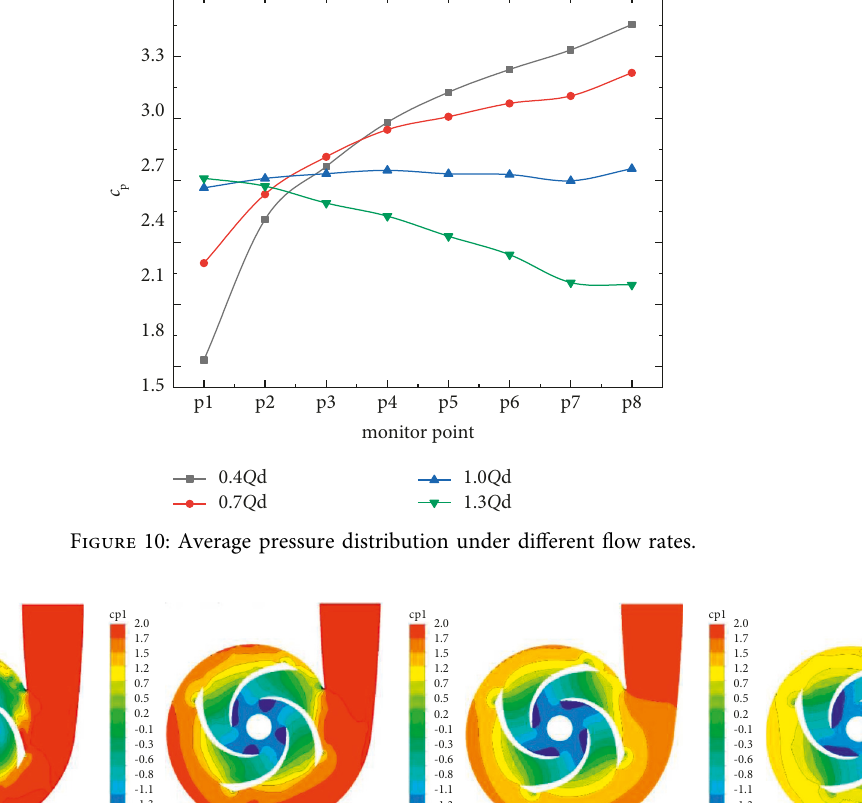
d , (b) 0.7 Q d , (c) 1.0 Q d , and (d) 1.3 Q d